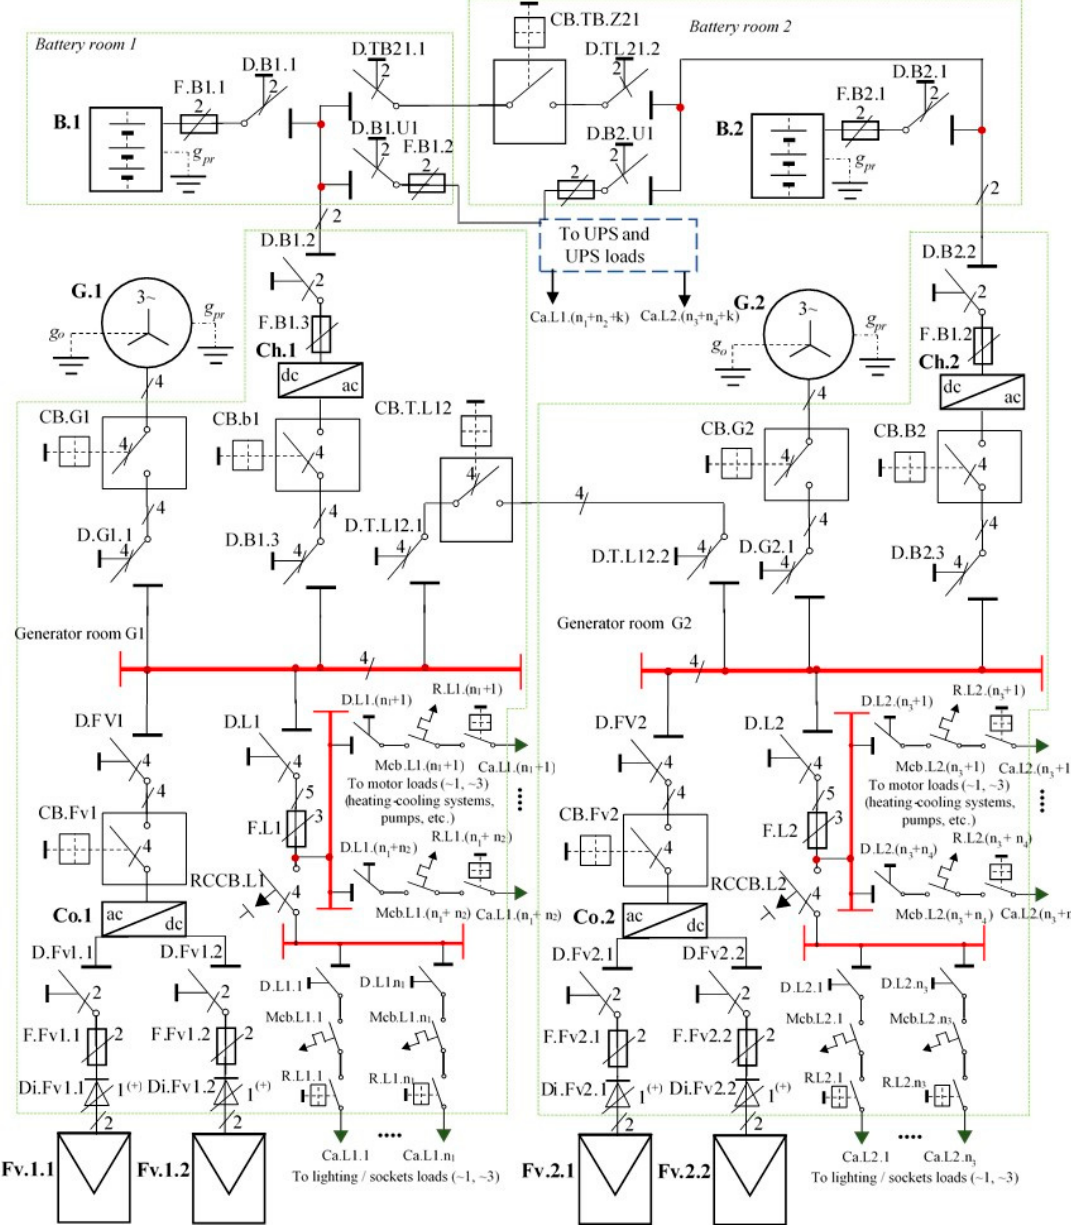
Figure 7. Typical single line diagram of an autonomous power system (back-up diesel engine electric generator—G, photovoltaic panels—FV, and battery storage system—B) for the electrode station building in Stachtoroi, Attica. (D: disconnector, F: fuse, CB: circuit breaker, Di: blocking diode, Mcb: mini circuit breaker, RCCB: residual current circuit breaker, R: relay switch, Ca: cable, Co: converter, Ch: charger, Fv: photovoltaic panel branch, B: battery, L: line, and T = interconnection).